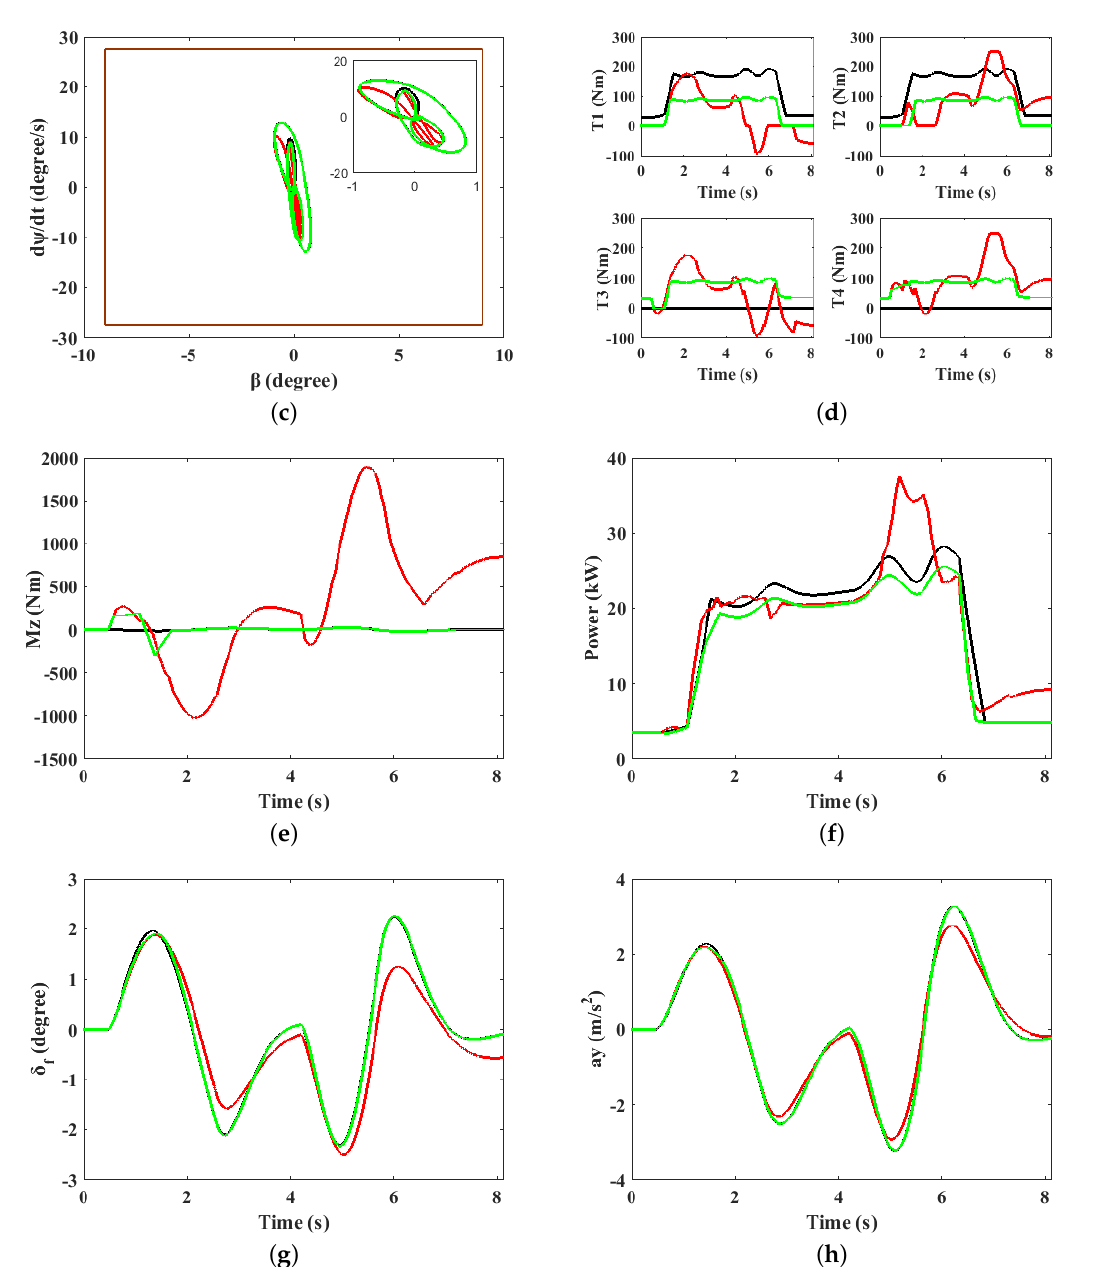
Figure 17. Acceleration during cornering with Motor I ( a ) Path; ( b ) Longitudinal velocity; ( c ) Working area; ( d ) Wheel torques; ( e ) Yaw moment; ( f ) Power; ( g ) Front steering angle; ( h ) Lateral